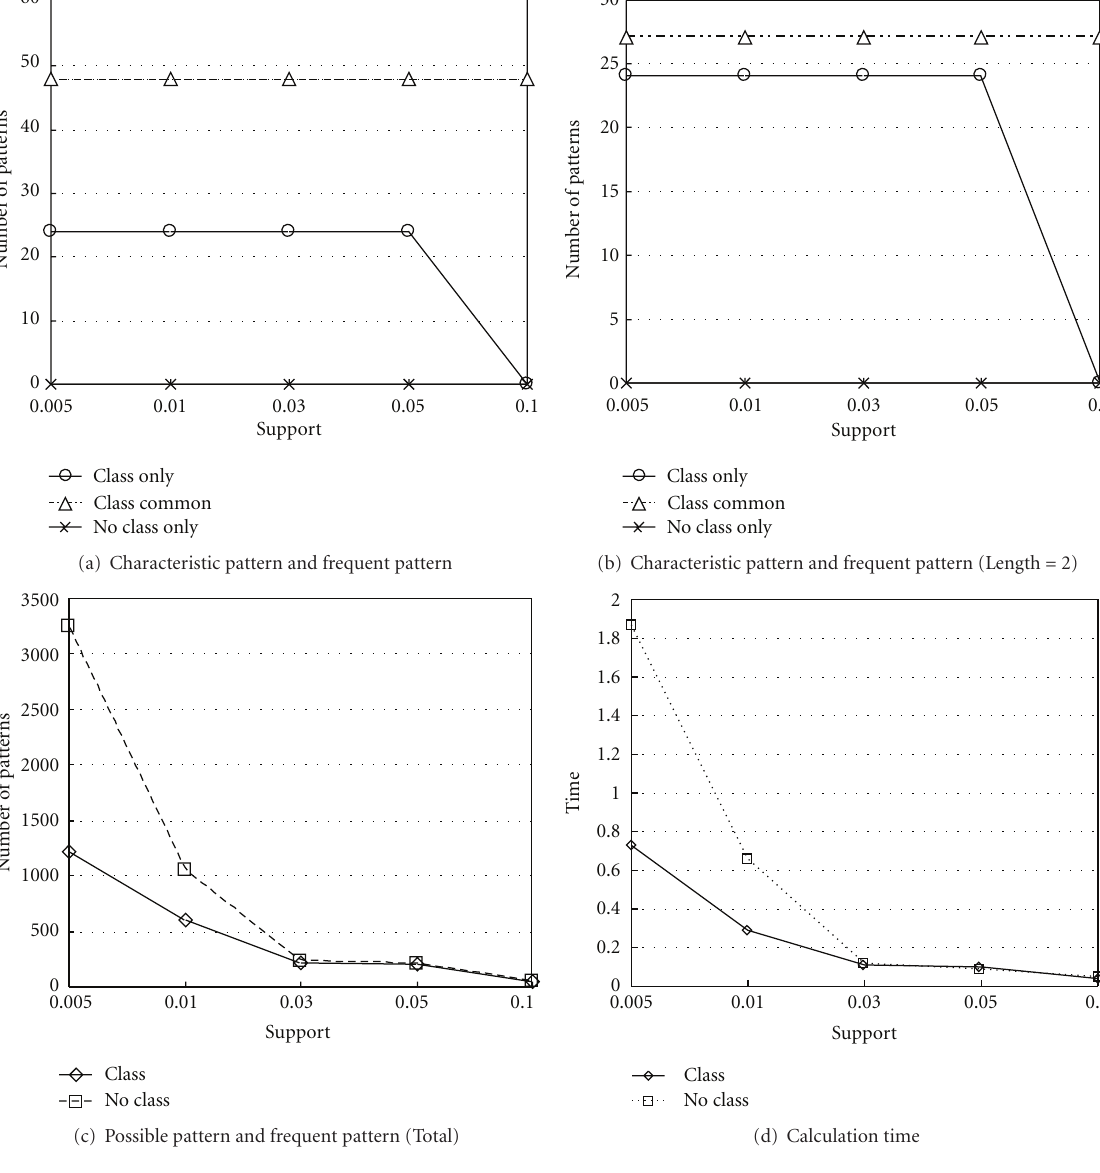
Figure 3: Experimental result in the case of the data set